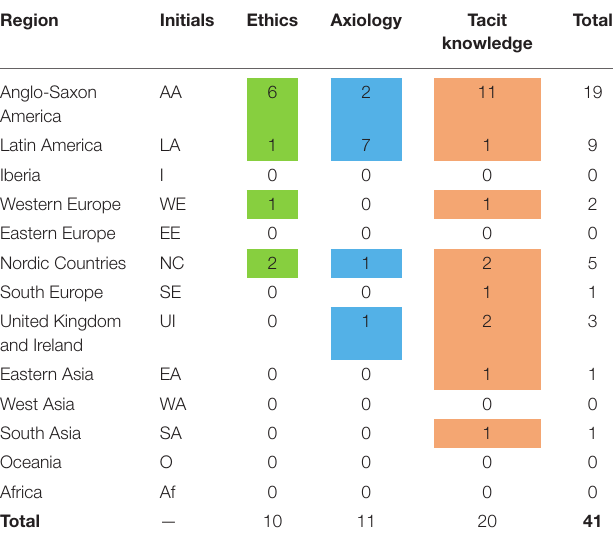
TABLE 2 | Regions of articles publication according to the three main themes.